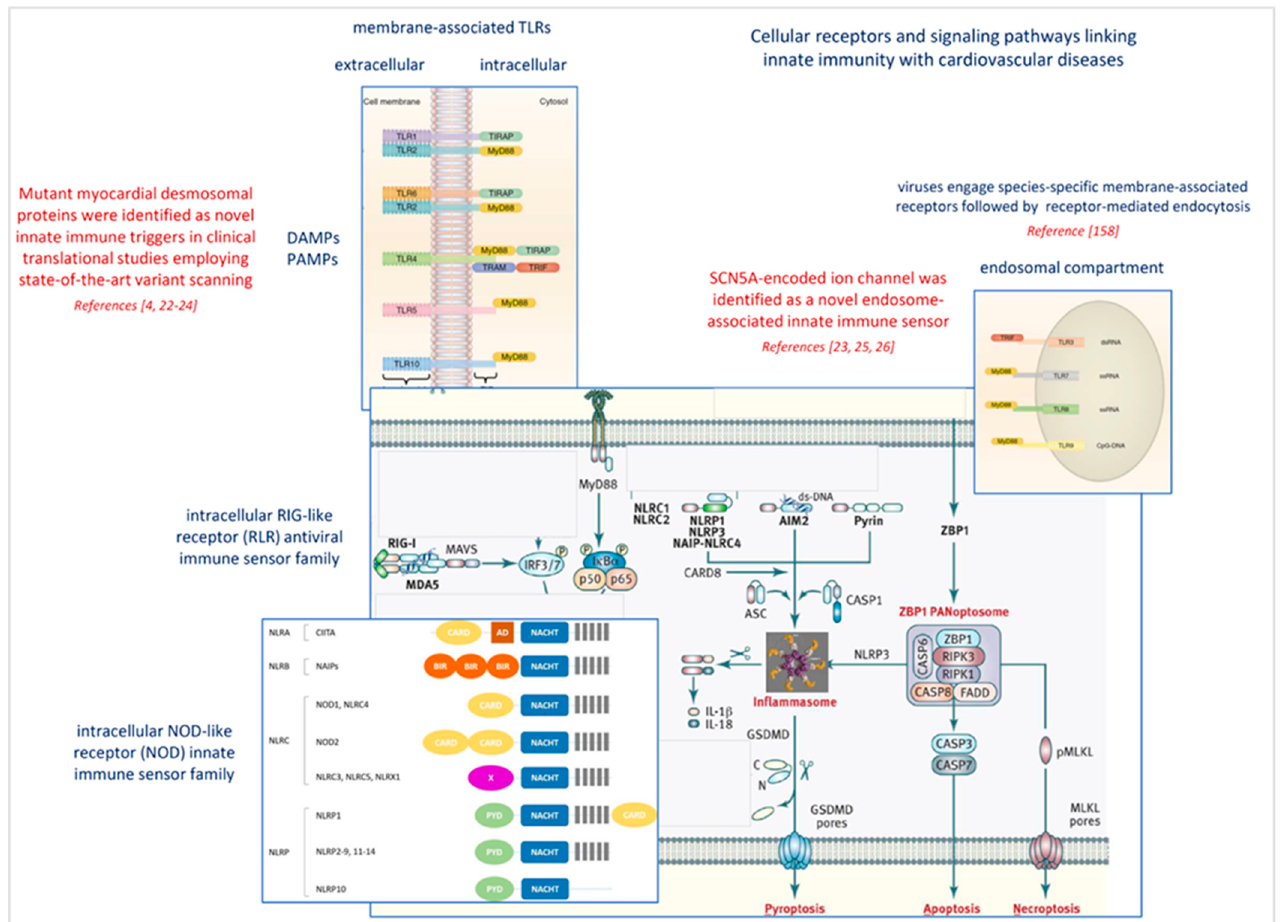
Figure 2. Cellular receptors and signaling pathways linking innate immunity with cardiovascular diseases. Pattern recognition receptors (PRRs) play a critical role in the activation of an innate im- mune response to invading pathogens, e.g., viruses (see chapter 3 below) or mutant or otherwise modified endogenous structures. PRRs enable recognition of pathogen-associated molecular pat- terns (PAMPs), or of endogenous molecules released from injured cells and tissue, designated dam- age-associated molecular patterns (DAMPs), acting as PRR ligands. Ligand–PRR interaction then triggers intracellular signaling pathways, ultimately inducing expression and release of a multitude of pro-inflammatory or antiviral cytokines. PRRs may be associated with the cell membrane (e.g., 10 Toll-like receptors—TLRs; C-type lectin receptors—CLRs), located within the cytosol (23 NOD-